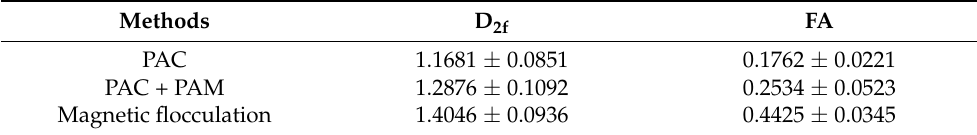
Table 6. Floc index parameters of three treatment methods.